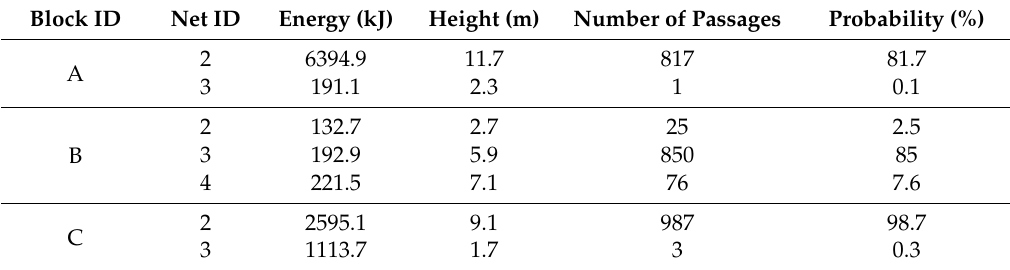
Table 6. Results of rockfall simulation with virtual net